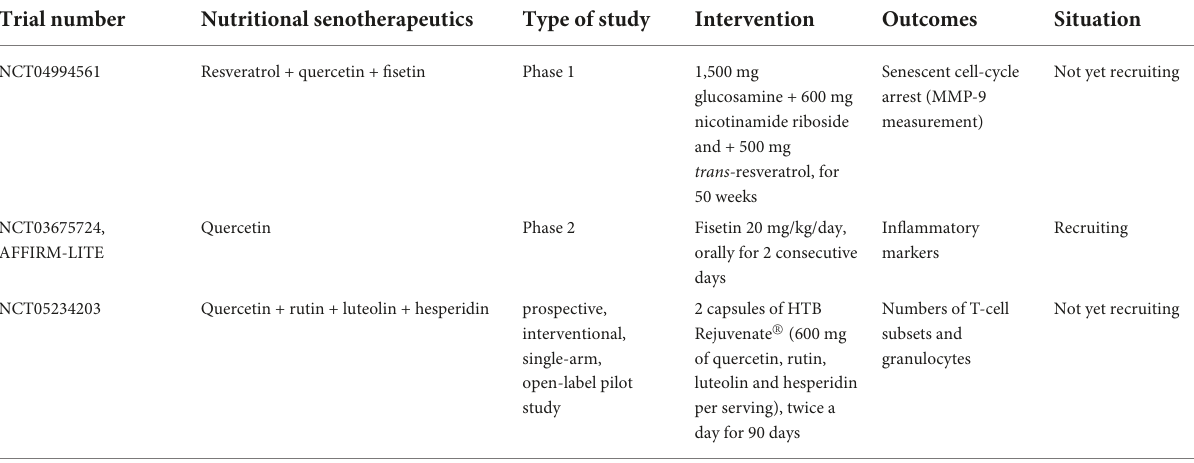
TABLE 4 Ongoing clinical trials aiming to evaluate nutritional senotherapeutics on immunosenescence, cellular and humoral components, and markers of inflammation and oxidative stress in aged individuals. Trial